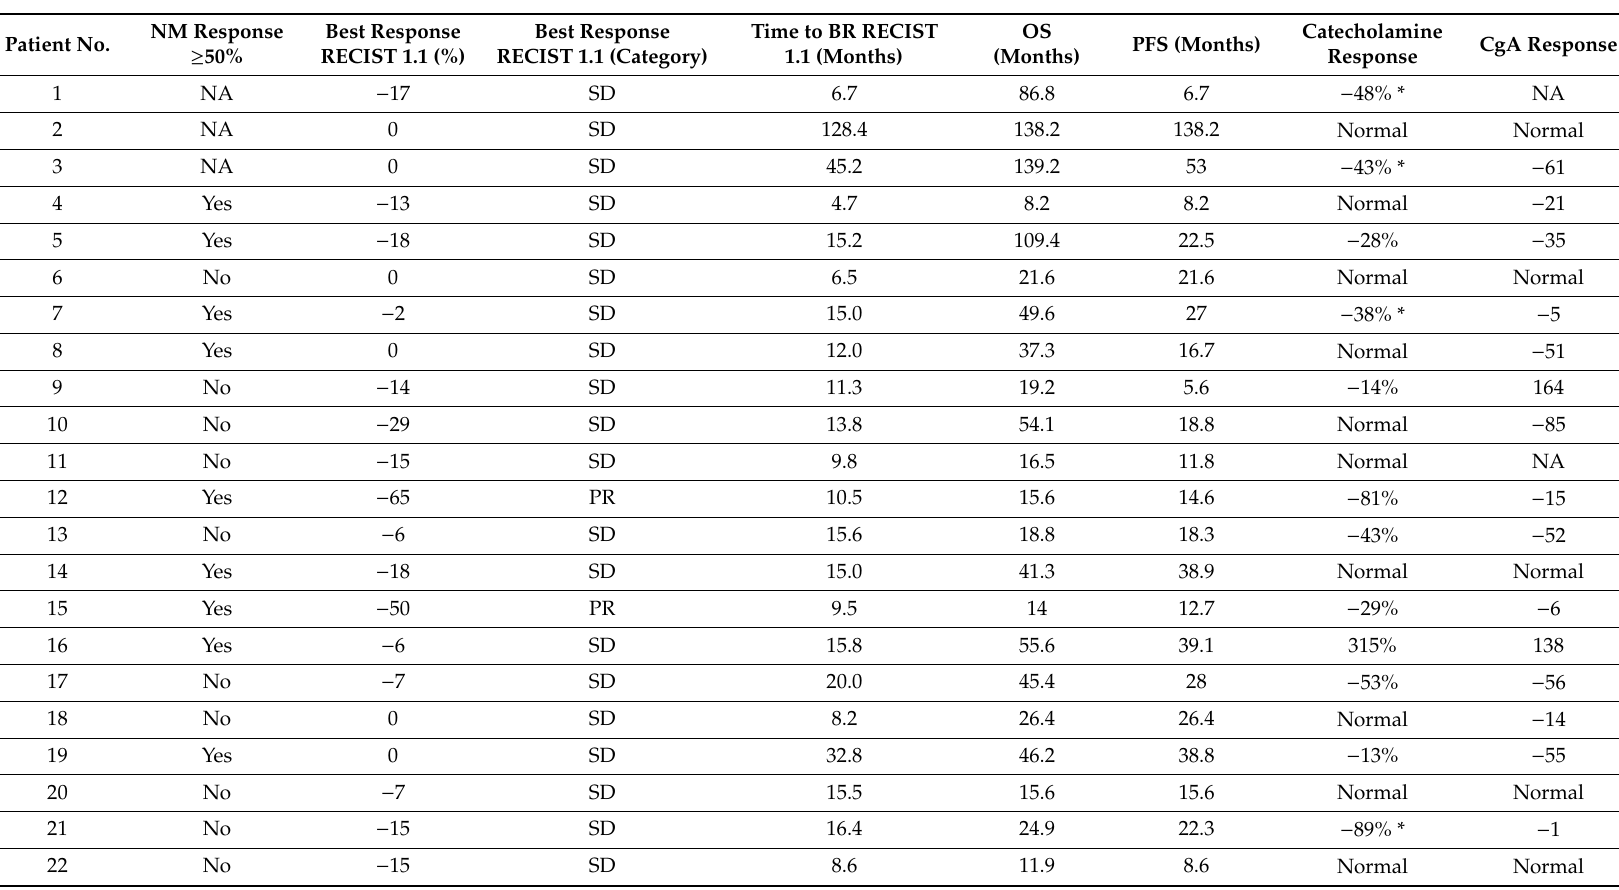
Table 3. Response rates for peptide receptor radiotherapy (PRRT) with 177 Lu-DOTATATE in 22 patients with pheochromocytoma or paraganglioma (PCC / PGL). Patient